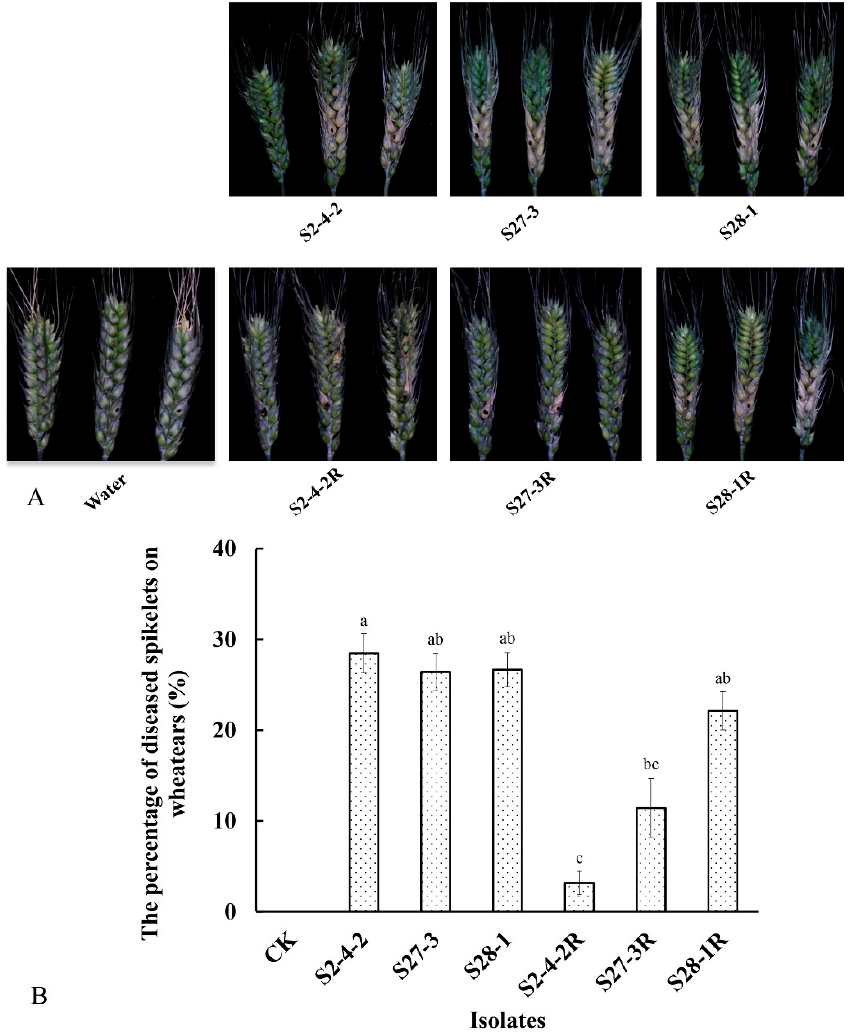
Figure 3. Pathogenicity of three pydiflumetofen-resistant mutants of F. graminearum . The top panels ( A ) show the lesions produced by both the resistant mutants (R) and their parental wild-type isolates on wheat spikelets at 14 dpi, while the graph below ( B ) shows the percentage of diseased grains in the spikelets. Data are the means of three replicates ± standard error (SE). Different lowercase letters above the columns indicate significant differences ( p ≤ 0.05) according to Fisher’s least significant difference test ( p ≤ 0.05).